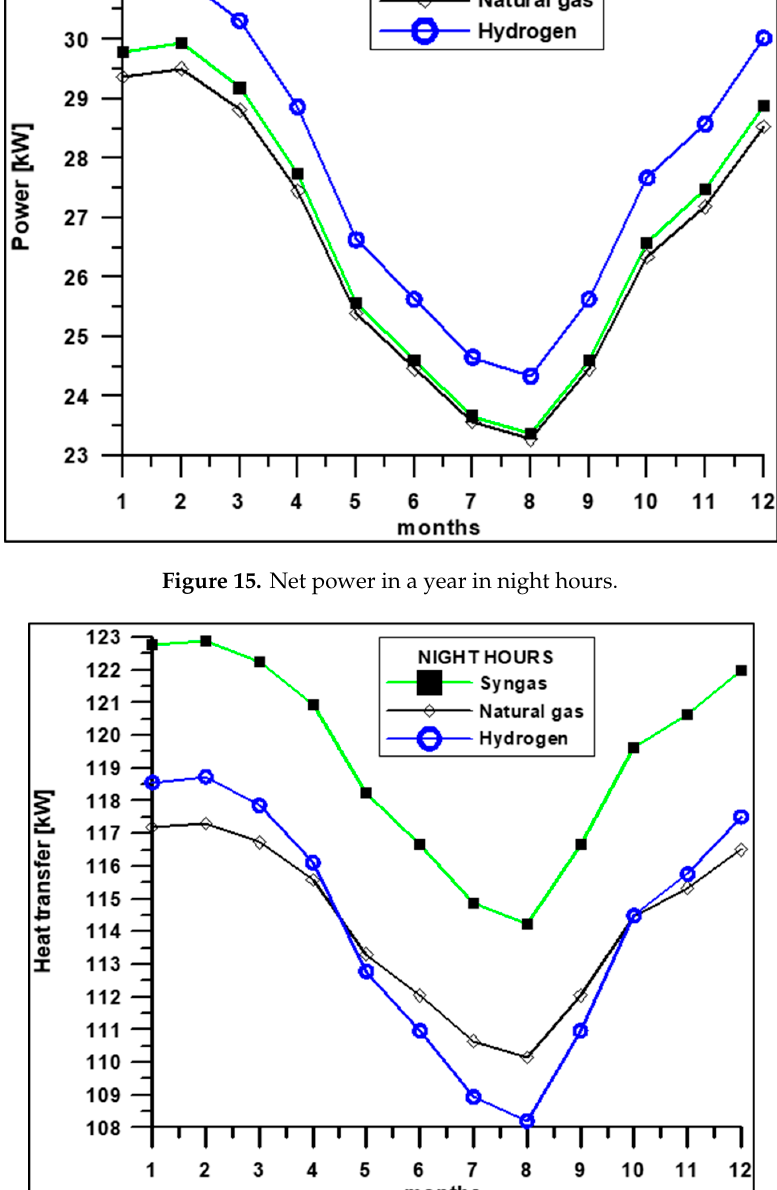
Figure 16. Heat transfer in cogeneration unit during year (night hours).